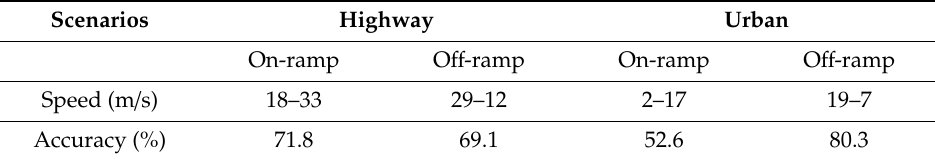
Table 2. Performance of motion detection for vehicle merging ramps